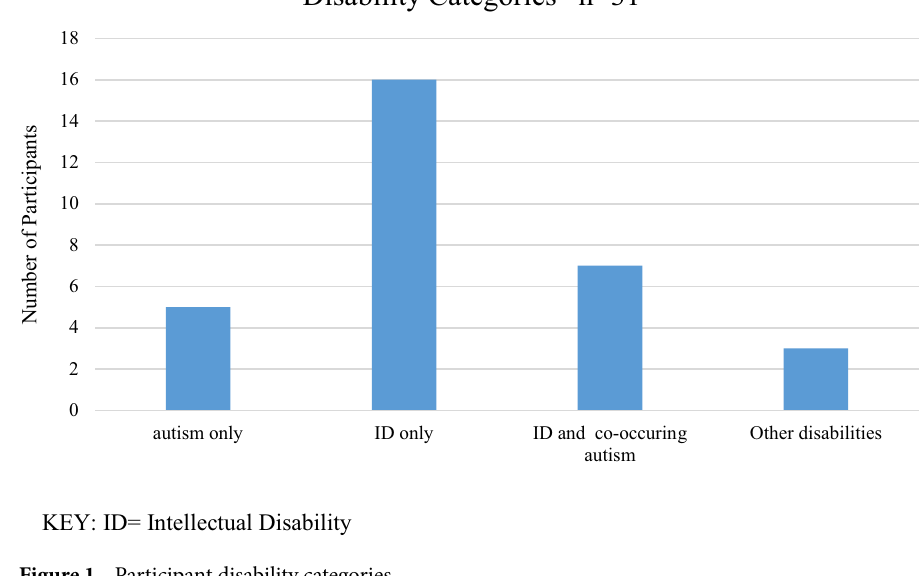
Figure 1. Participant disability